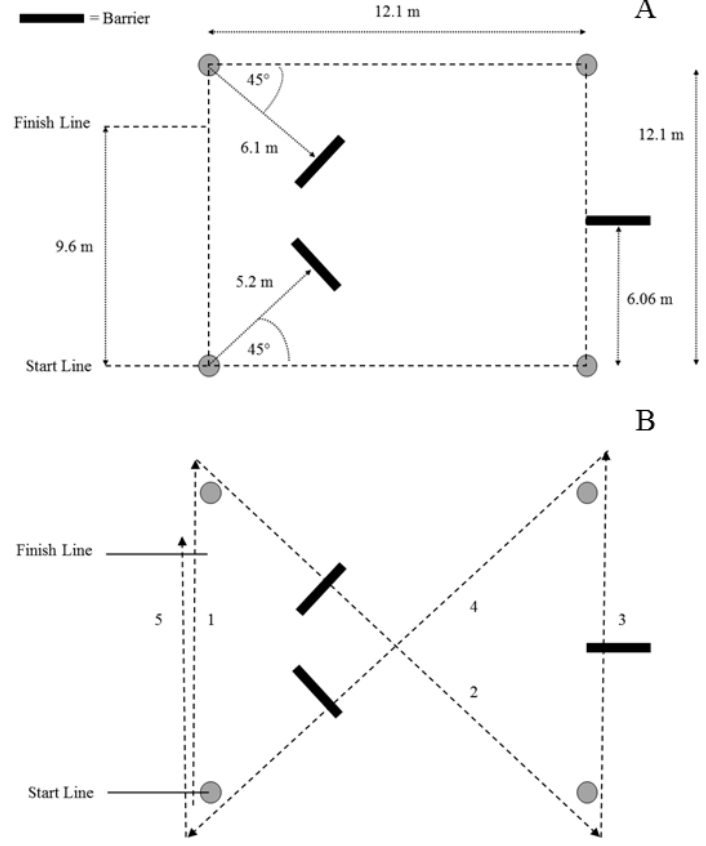
Figure 1. The 75PR dimensions in meters (m; ( A )) and the running direction (numbered in order; ( B )).